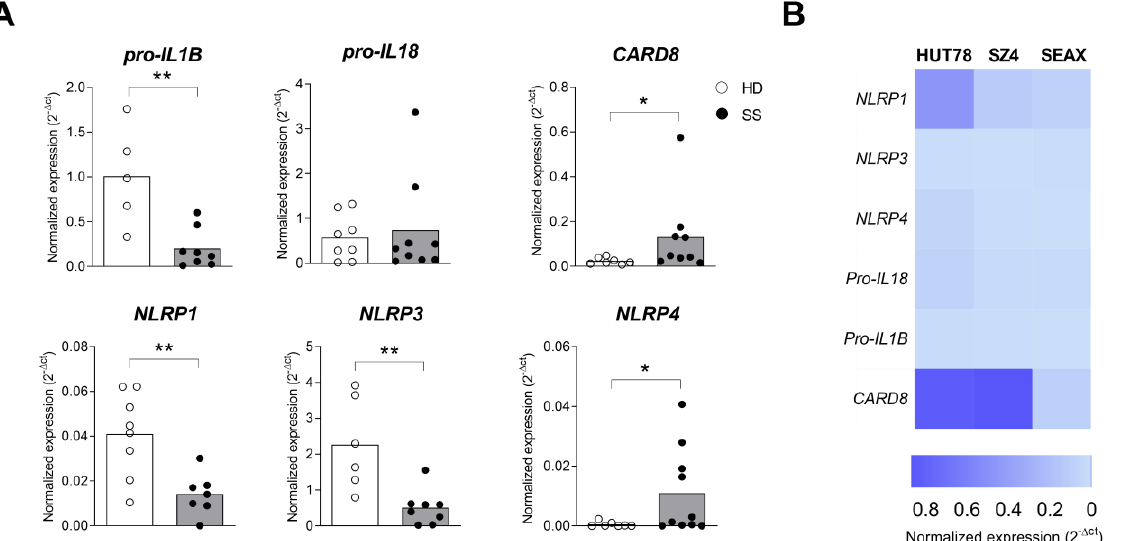
Figure 3. Altered inflammasome transcript expressions in peripheral blood mononuclear cells from SS patients. Expressions of NLRP1 , NLRP3 , NLRP4 , pro-IL18 , pro-IL1B and CARD8 were analyzed in PBMCs from SS patients ( n = 7–10, closed circle), healthy control individuals ( n = 5–8, open circle) and in SS cell lines by qRT-PCR. The data were normalized to GAPDH and shown either by median ( A ) for SS patient samples or by heatmap ( B ) in SS cell lines. * p ≤ 0.05 and ** p ≤ 0.01.